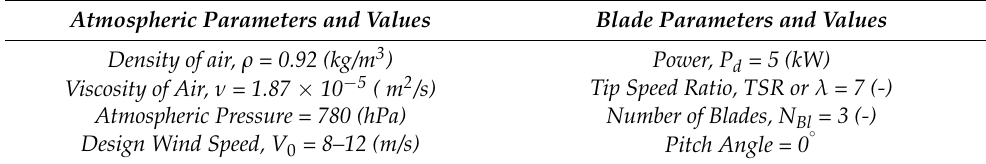
Table 1. Design parameters and